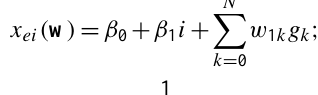
Tehran, where the simulated NO 2 columns are much lower than the measurement-based ones probably due to strongly underestimated NO x emission rates (Konovalov et al., 2006a,